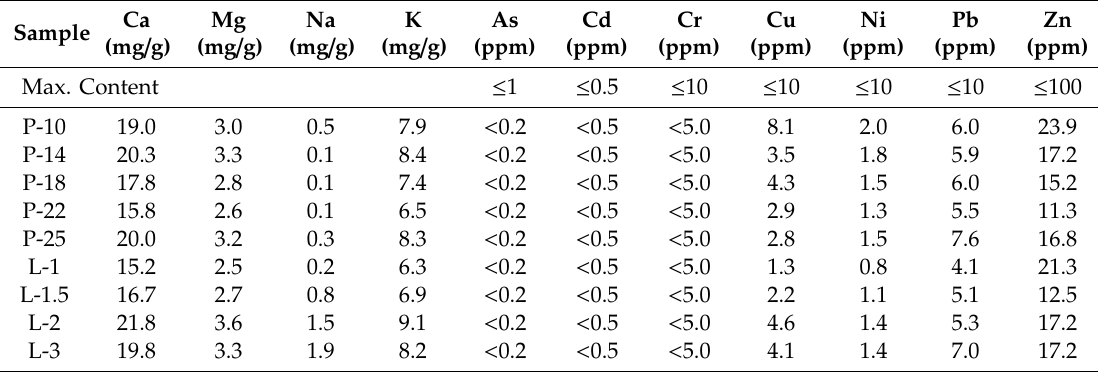
Table 5. Metal composition of